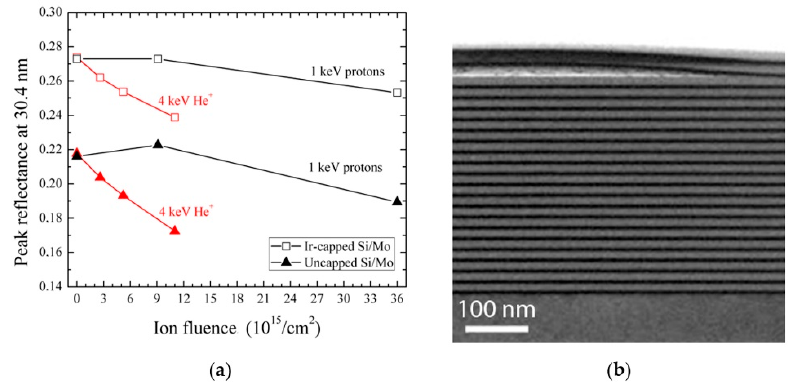
Figure 4. E ff ect of charged particles on multilayer coating ( a ) Evolution of the EUV reflectance at 30.4 nm of an uncapped and Ir-capped Si / Mo multilayer coating versus 1 keV proton and 4 keV He ion fluence (data from ref. [119,120]). ( b ) Delamination occurring on a Si / Mo multilayer under a 1 keV proton irradiation with a fluence of 3.6 · 10 16 p / cm 2 (image from Ref. [119]—2011 OSA).